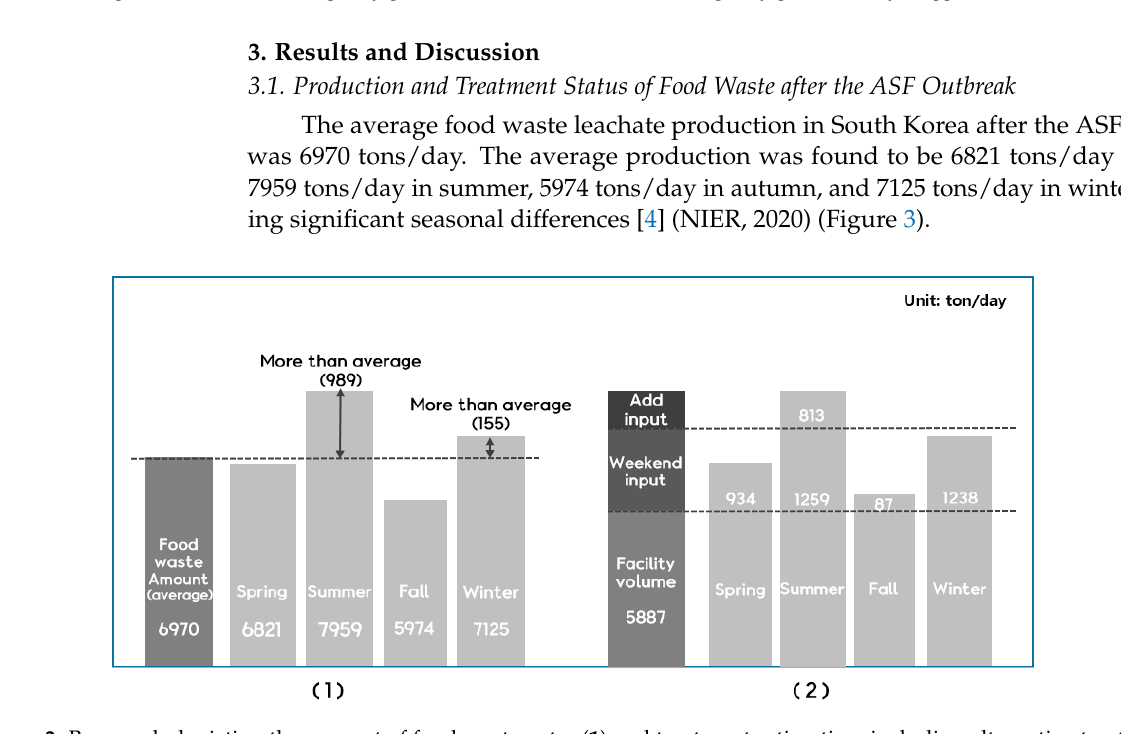
Figure 3. Bar graph depicting the amount of food wastewater ( 1 ) and treatment estimation, including alternative treatment methods ( 2